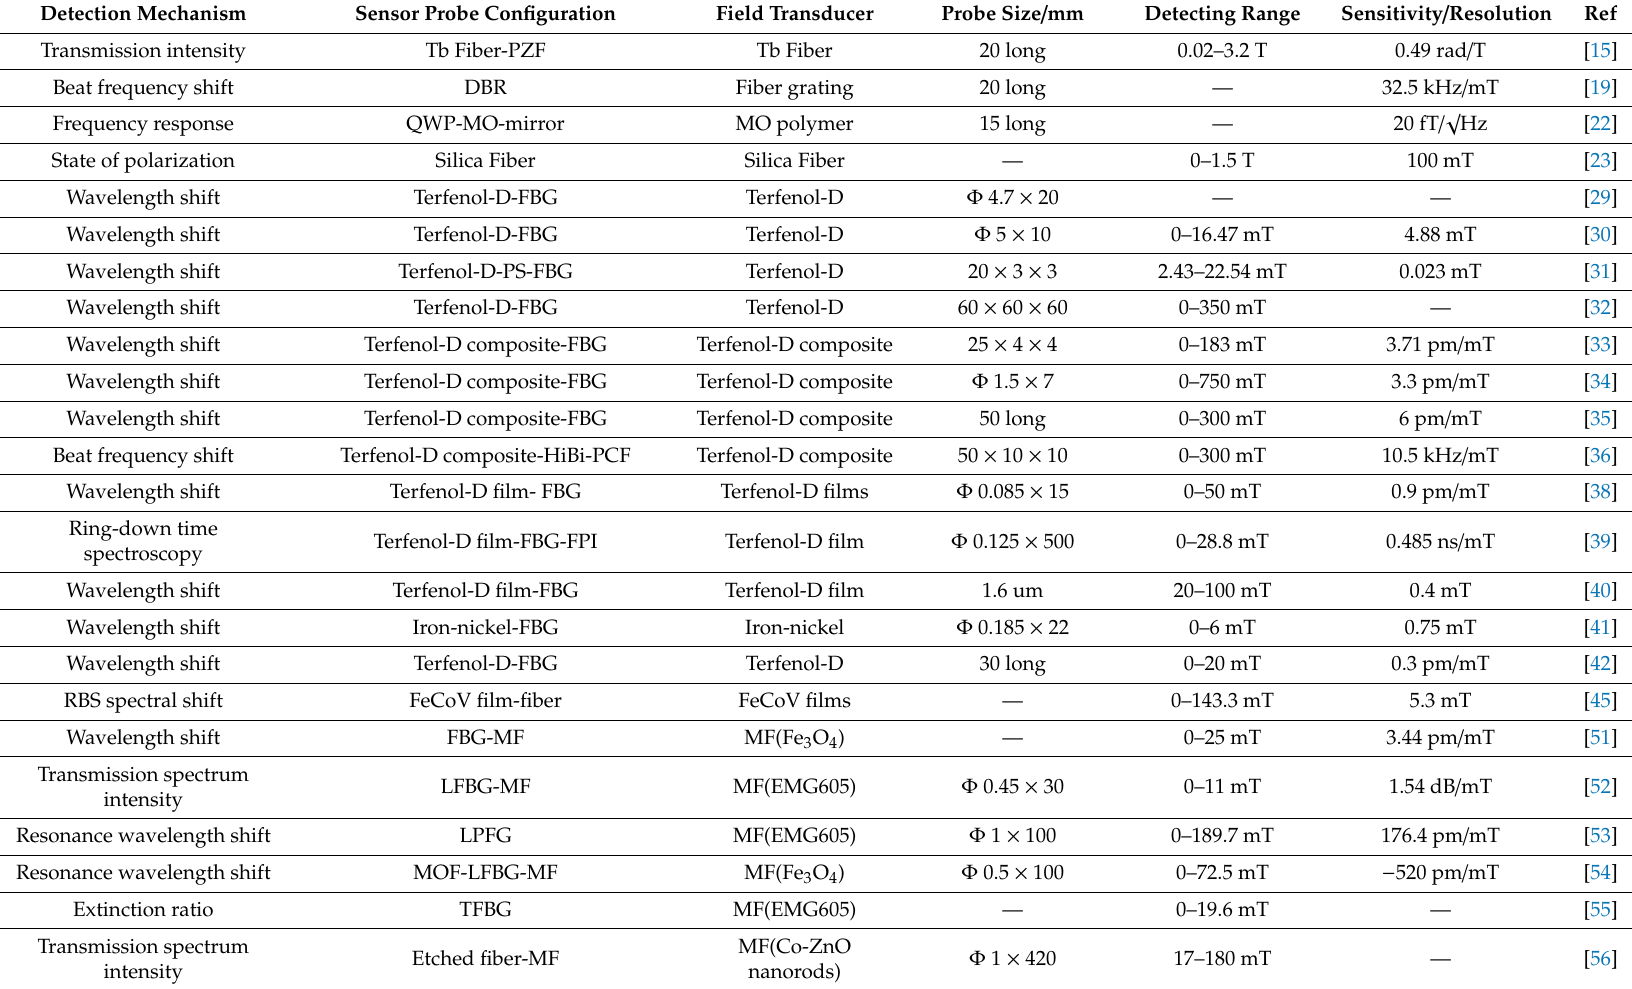
Table A1. Performance parameters of optical fiber magnetic field